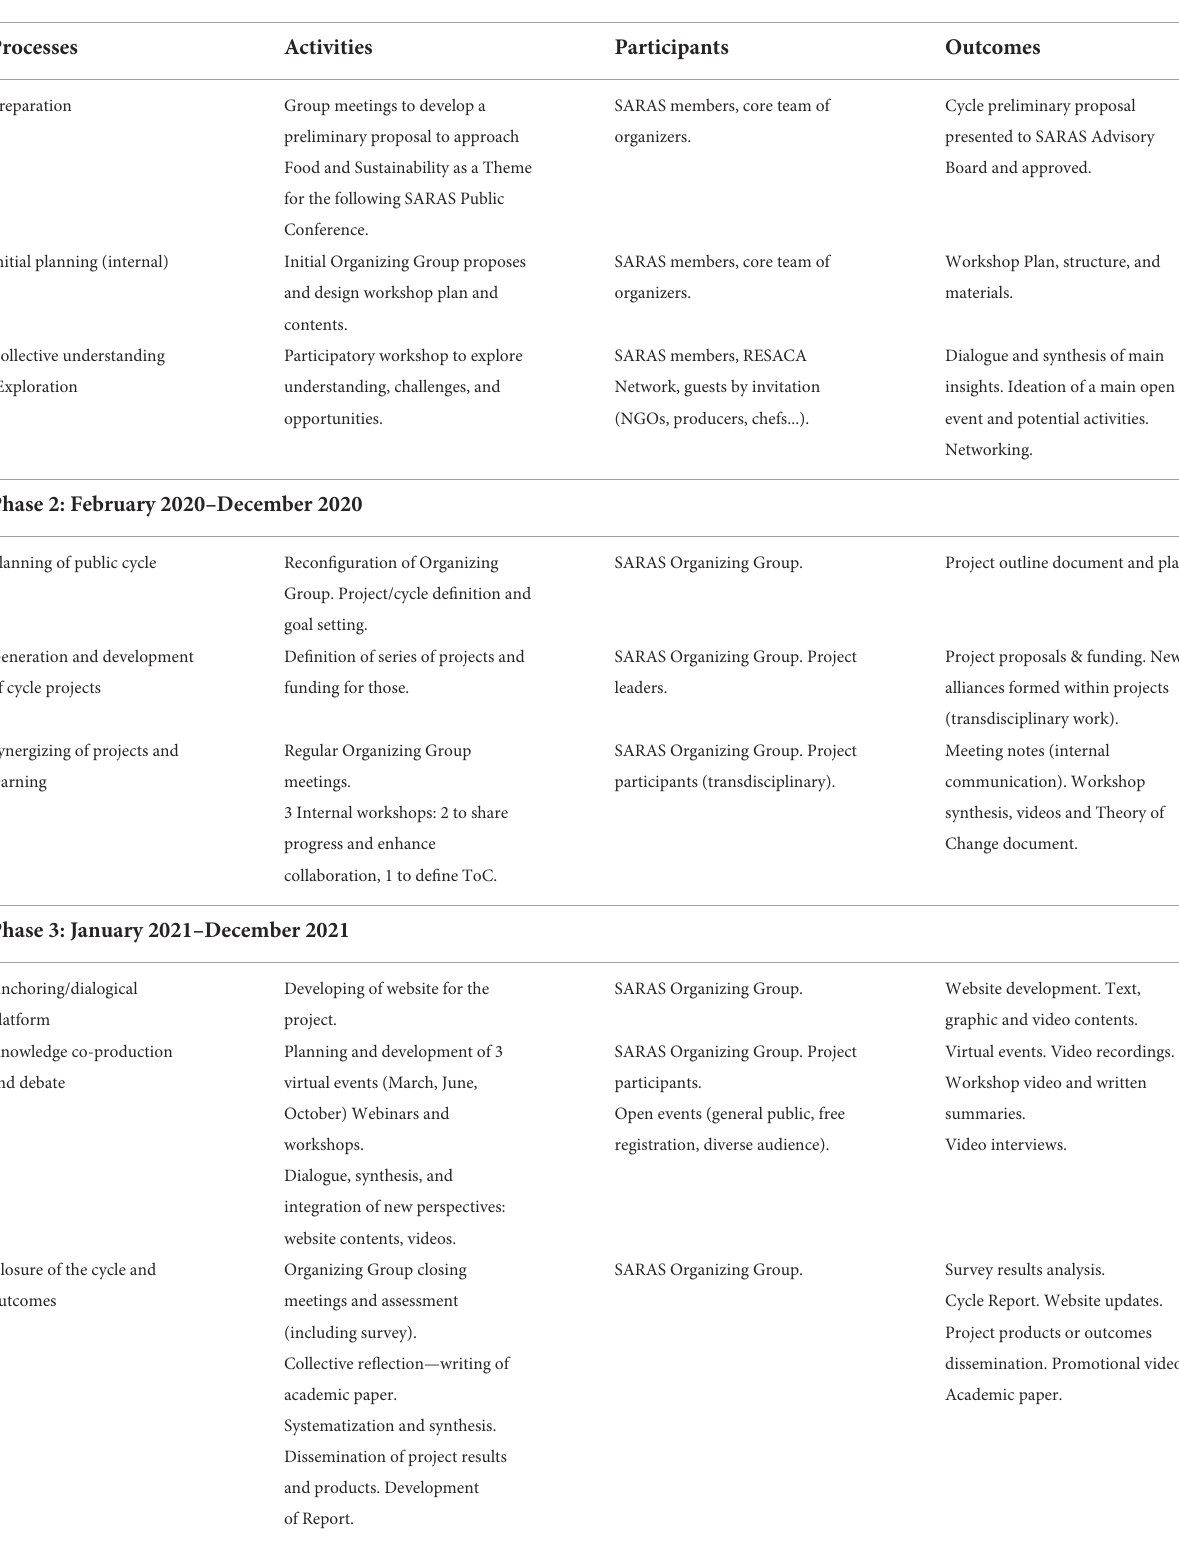
TABLE 2 Breakdown of SARAS cycle phases: We display the processes, activities, type of participants engaged, and main outcomes